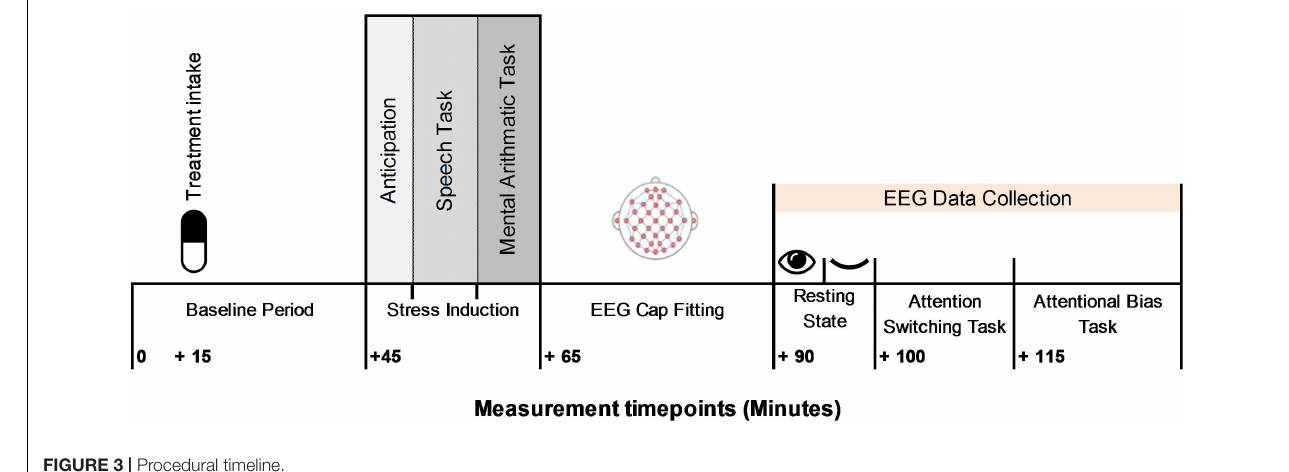
FIGURE 3 | Procedural timeline. TABLE 2 | Summary characteristics of sample receiving each